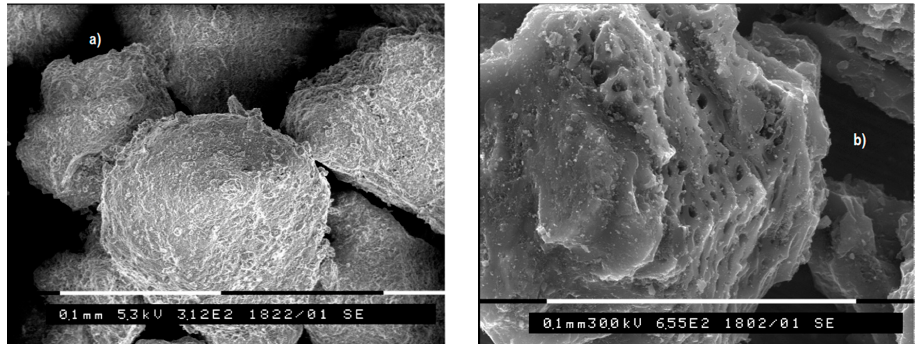
Figure 1. Examples of powder particles with high SSA: fractal-like topography of montmorillonite ( a ) with SSA ≈ 1000 m 2 ∙ g − 1 (nanometric pores) and activate black coal ( b ) with surface area around 1100 m 2 ∙ g − 1 and pore size of approximately 5 μ m (maximum)—its surface seems to be non-homogenous, i.e. , non-fractal. Scale bars 0.1 mm.